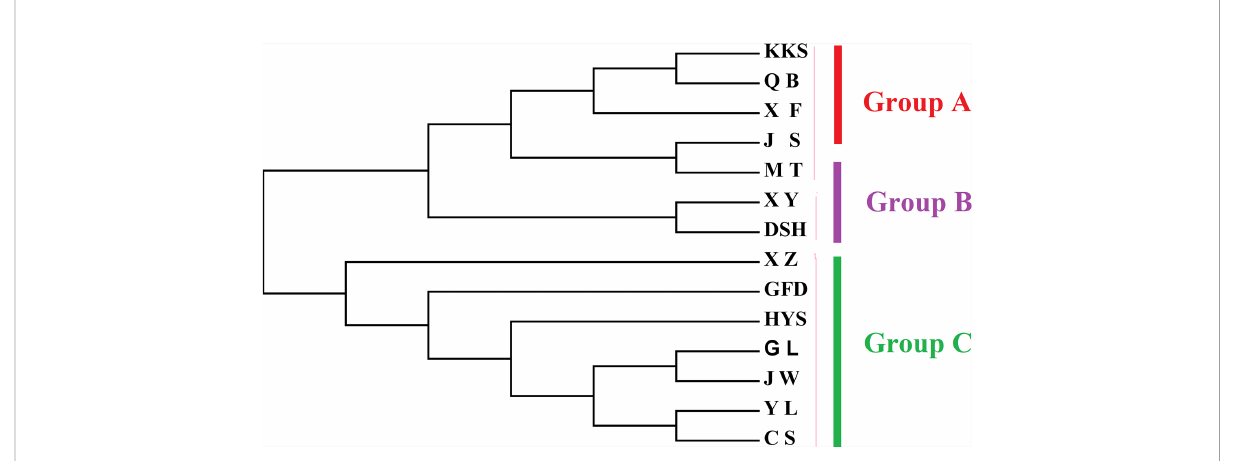
FIGURE 8 NJ tree of Ch. utilis populations based on Nei ’ s genetic